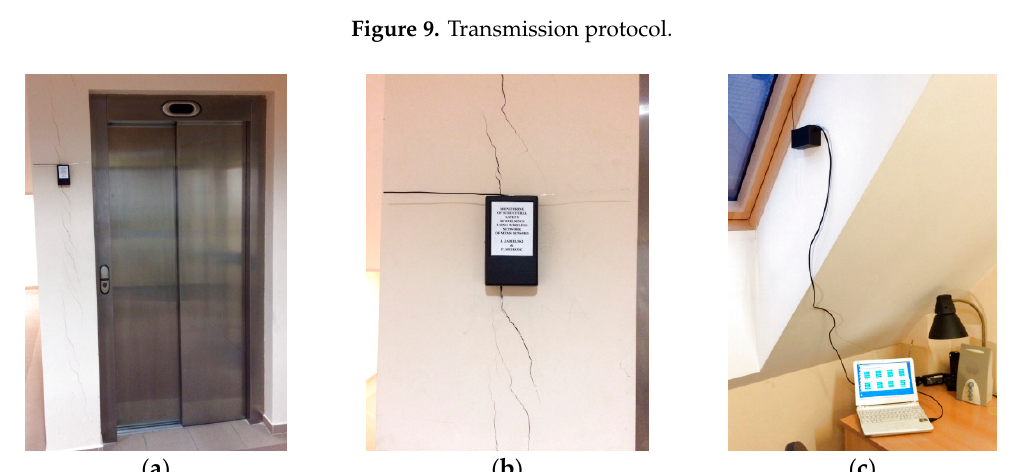
Figure 9. Transmission protocol.